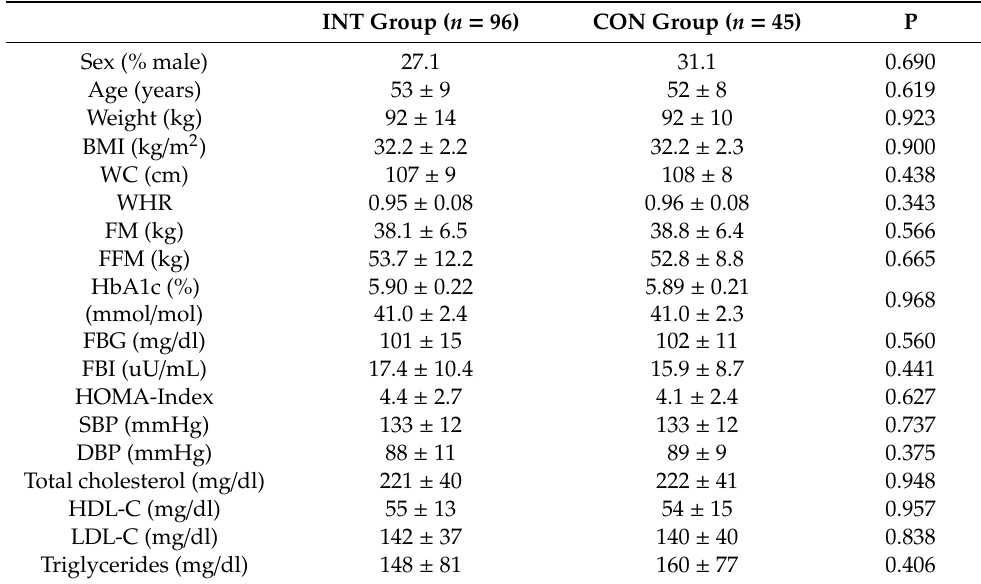
Table 1. Baseline characteristics. INT, intervention; CON,